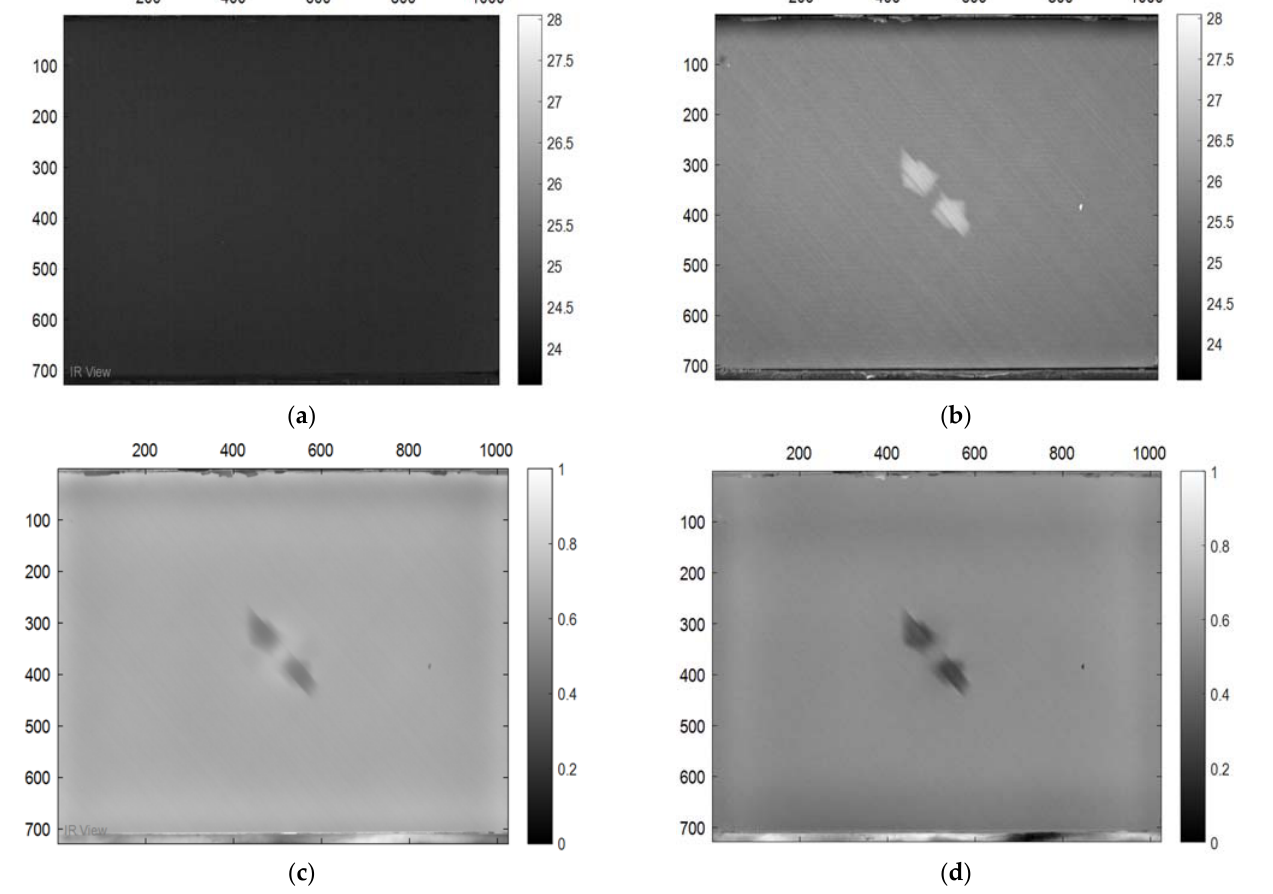
Figure 5. Images Processing Results. ( a ) Cold image. ( b ) Raw Image. ( c ) BCT Image. ( d ) PPT Image.